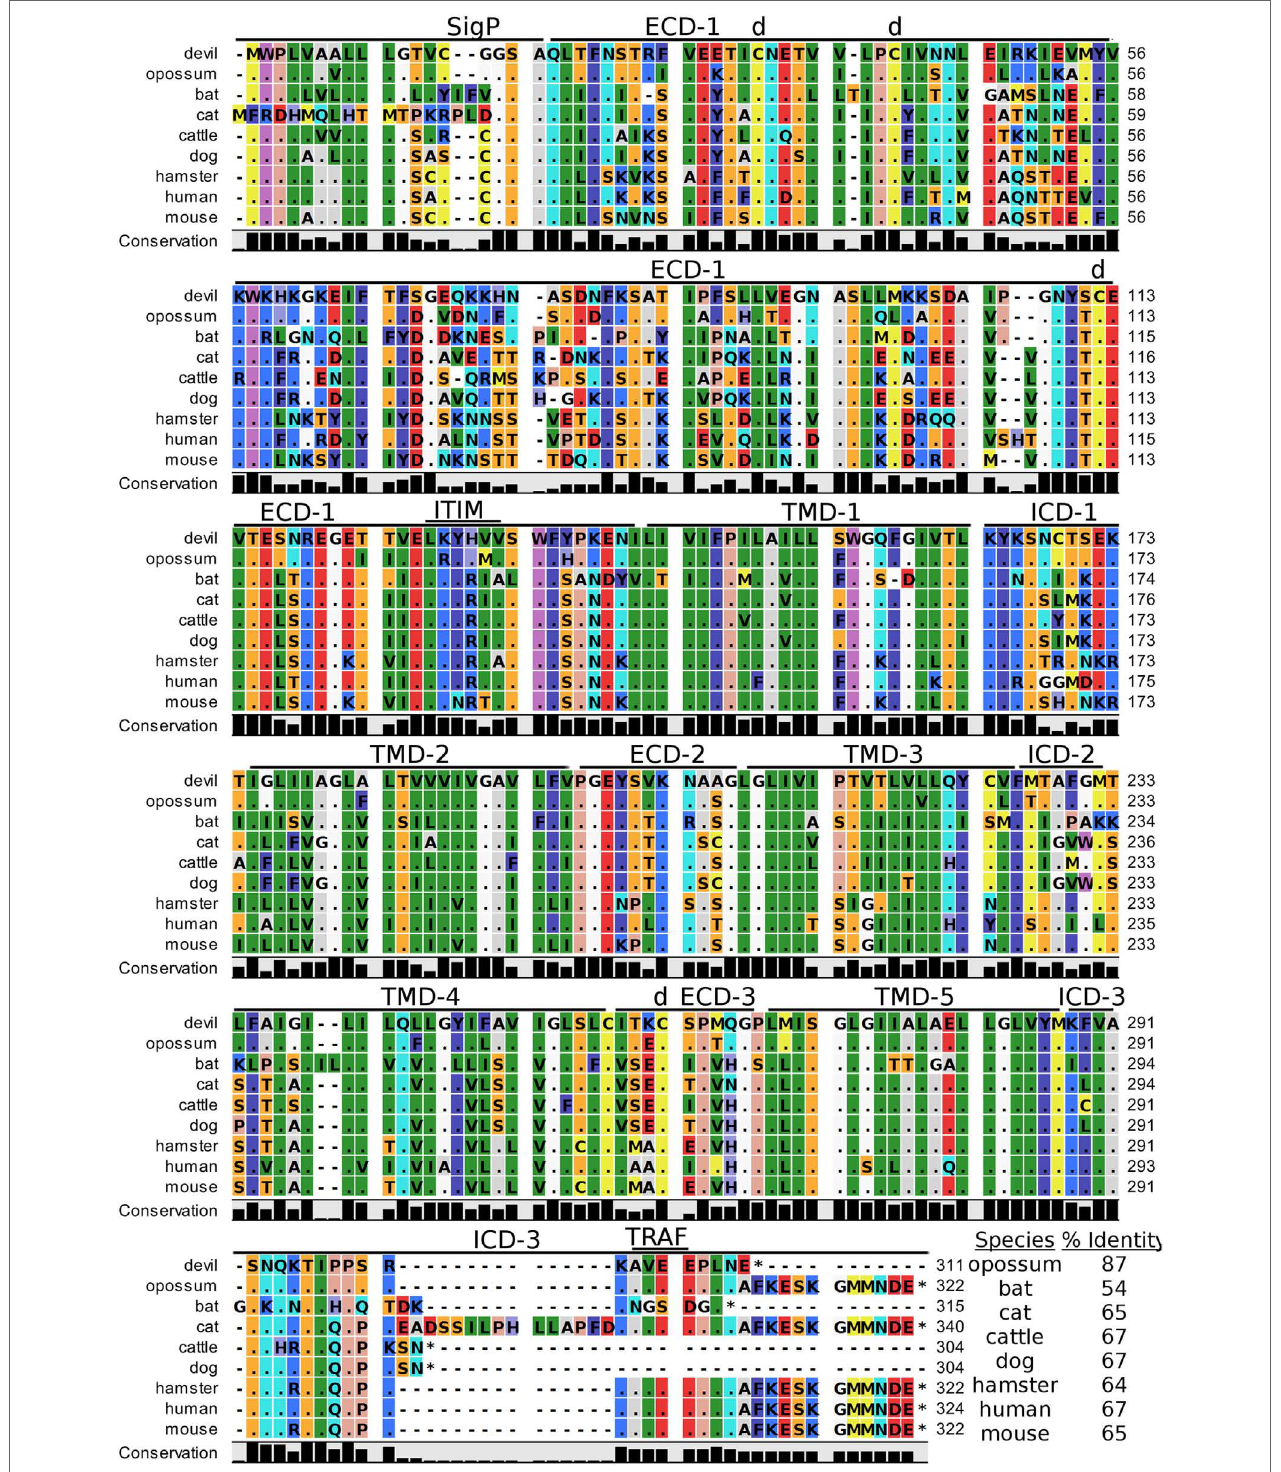
FigUre 8 | alignment of cD47 reference genes for nine species . The predicted signal peptides (SigP), extracellular domains (ECDs), transmembrane domains (TMDs), and intracellular domain (ICD) are demarcated with bars. “d” above the alignment represents predicted disulfide bonds. “TRAF” indicates a potential TRAF1/2-binding site and immunoreceptor tyrosine-based inhibitory motif (ITIM) marks a putative ITIM motif predicted in the ECD. The black bar graphs below the alignment represent the conservation of amino acids across all nine species. The percent amino acid sequence identity between devils and other species is shown in the bottom right corner of the